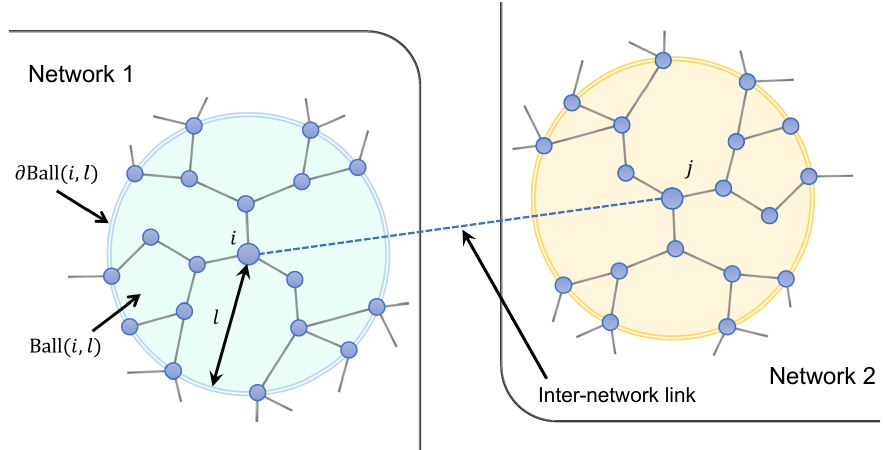
Figure 2. Expression of collective influence (CI). CI i is depicted in Network 1. Ball ( i , l ) is the area of influence of node i , and ∂ Ball ( i , l ) corresponds to the edge of Ball ( i , l ) . Networks 1 and 2 are interdependent via an internetwork